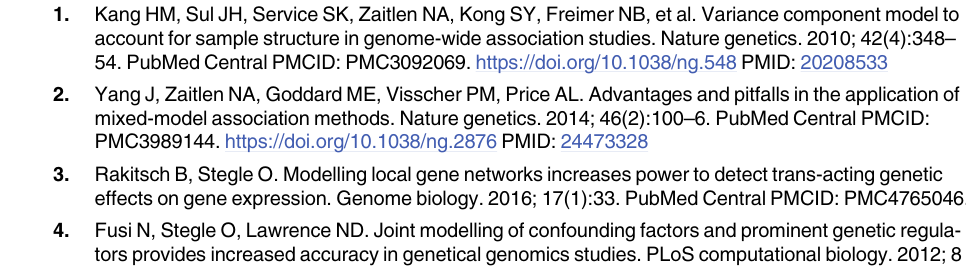
S18 Fig. Manhattan plot in the interaction locus for C-reactive protein using single-variant interaction tests on imputed variants. Shown is the Manhattan plot for C-reactive protein using single-variant interaction tests applied to common variants (MAF > 0.5%) on imputed data. Vertical grey lines indicate the 100kb region with significant genotype-sex interaction (FWER = 10%) detected using iSet. Non-imputed typed variants are highlighted in red, showing that for this locus imputation strategies did not increase the power of single-variant methods. (PDF) S19 Fig. The interaction for C-Reactive protein on chromosome 1 is a male-specific effect. ( a ) Local Manhattan plot (1Mb around significant region) for single-variant association tests, either considering males (black) or females (pink). For comparison, shown are also the P val- ues from the iSet (red), mtSet (green) and stSet (grey). ( b ) C-Reactive protein level stratified by different alleles of rs4660378 (lead SNP identified in the analysis using male individuals only). Rho in the caption correspond to the Spearman rank correlation coefficient and the corre- sponding P value, both for male and female individuals.